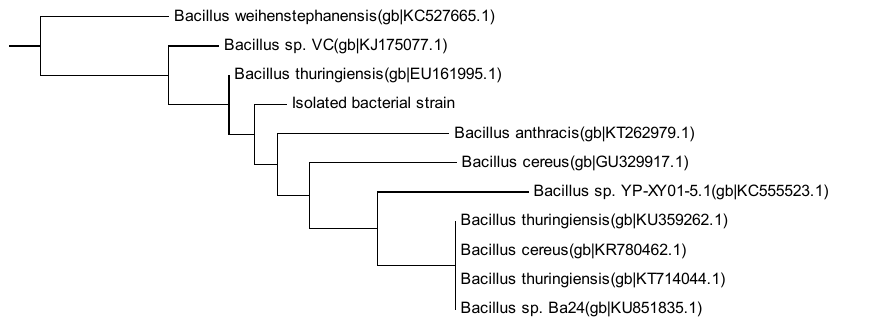
Figure 4. Neighbor ‐ joining tree of the isolated bacteria. The unknown strain is the isolated bacteria with 93% similarity to Bacillus sp.